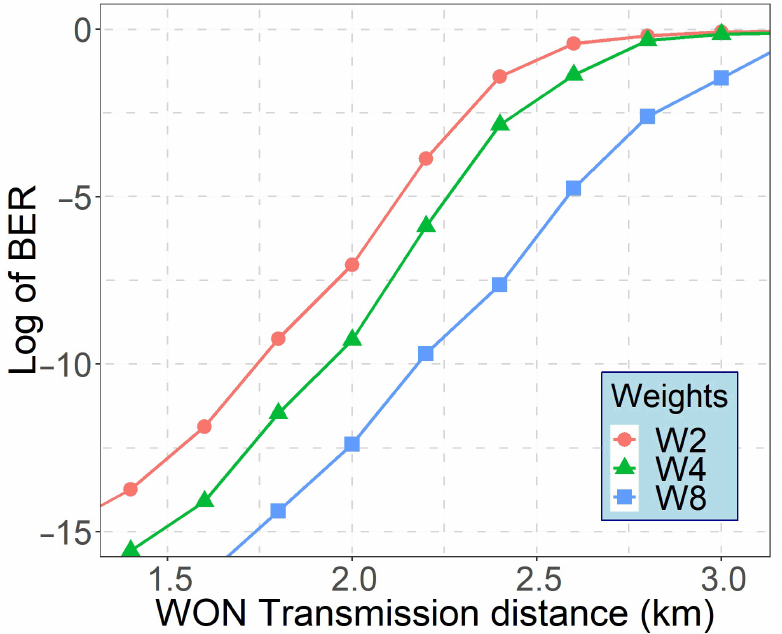
Figure 9. Probability of error versus transmission distance in moderate turbulence for concurrently transmitting users with weights 2, 4 and